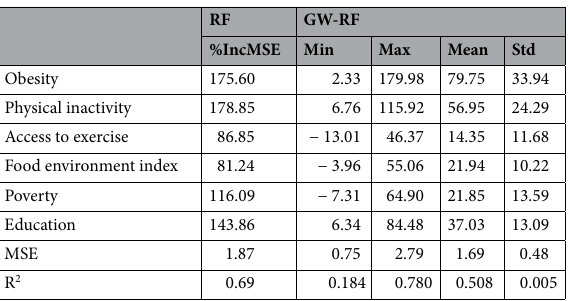
Table 2. Summary results of random forest (RF) and geographically weighted random forest regression (GW- RF) models. Both models were trained with 5 years of mean data (2013–2017) of 3108 counties. %IncMSE: mean increase in MSE, MSE: mean squared